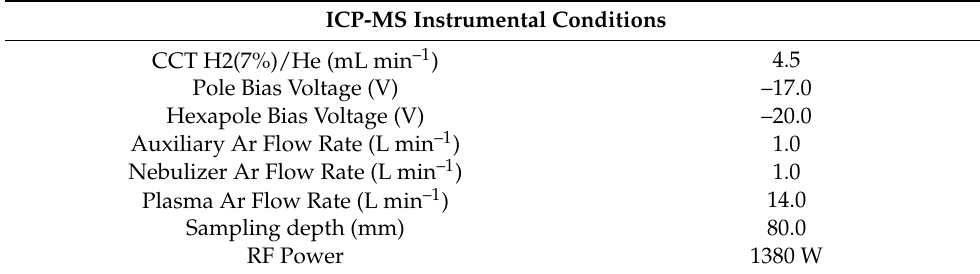
Table 2. ICP-MS instrumental conditions for the metallic elements and metalloid determination in the mushroom